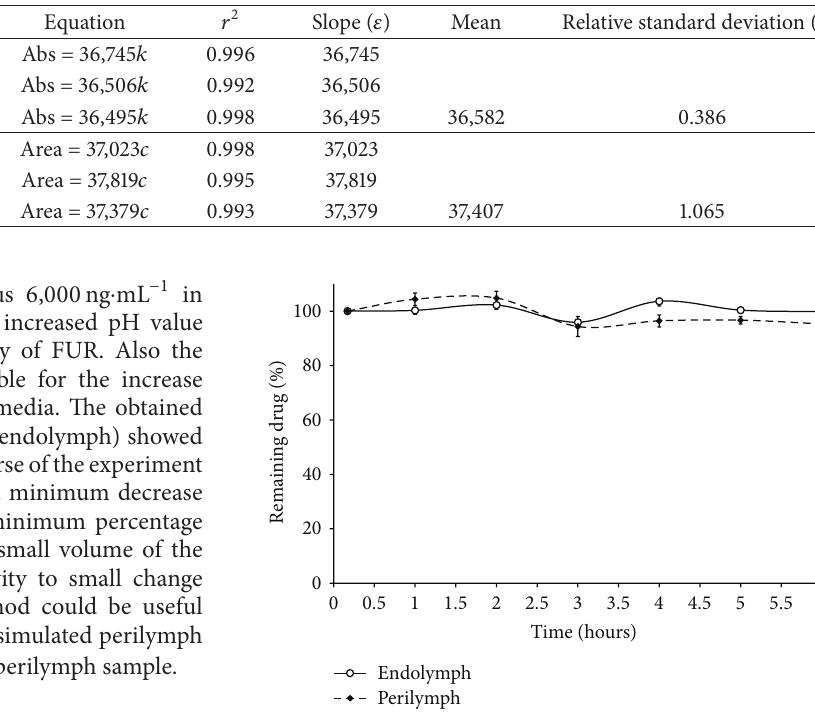
Table 6: Determination of the molar absorptivity by UV spectrophotometry and HPLC.